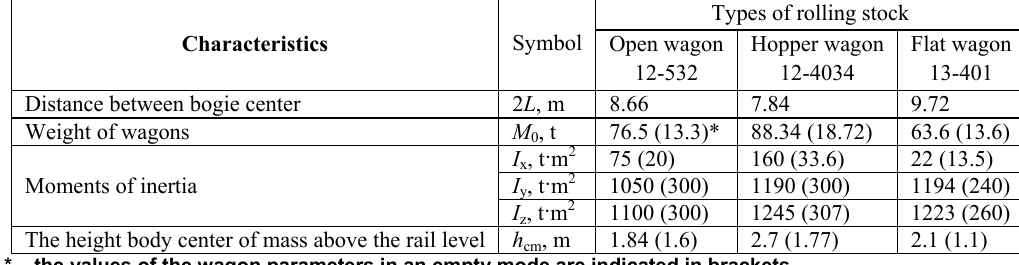
Table 1. Inertial and geometric characteristics of wagons with different loading modes